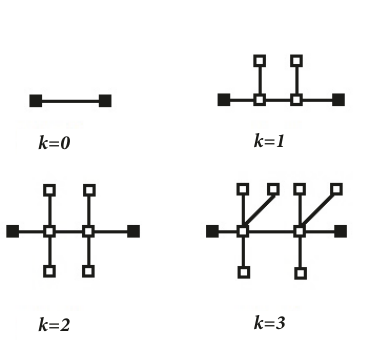
Figure 1: Construction model for next generations of the fractal trees.